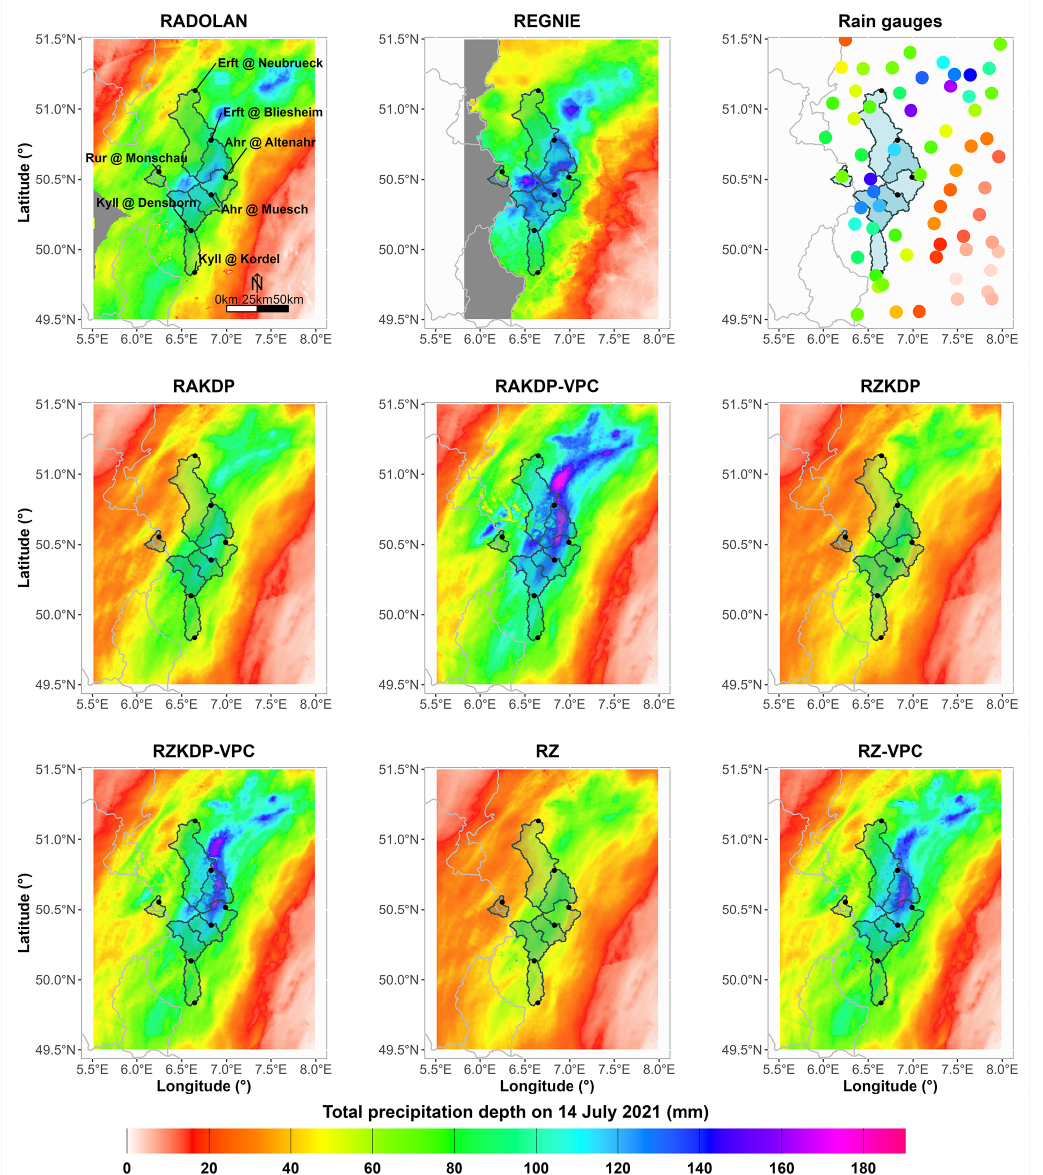
Figure 2. Total precipitation depths for 14 July 2021 (between 14 July 2021 00:00UTC and 15 July 2021 00:00UTC) from nine QPE products (Table 2) over the study region. Note that REGNIE is available only at the daily time step and that it covers only ∼ 50% of the area of the catchment drained by the Rur at